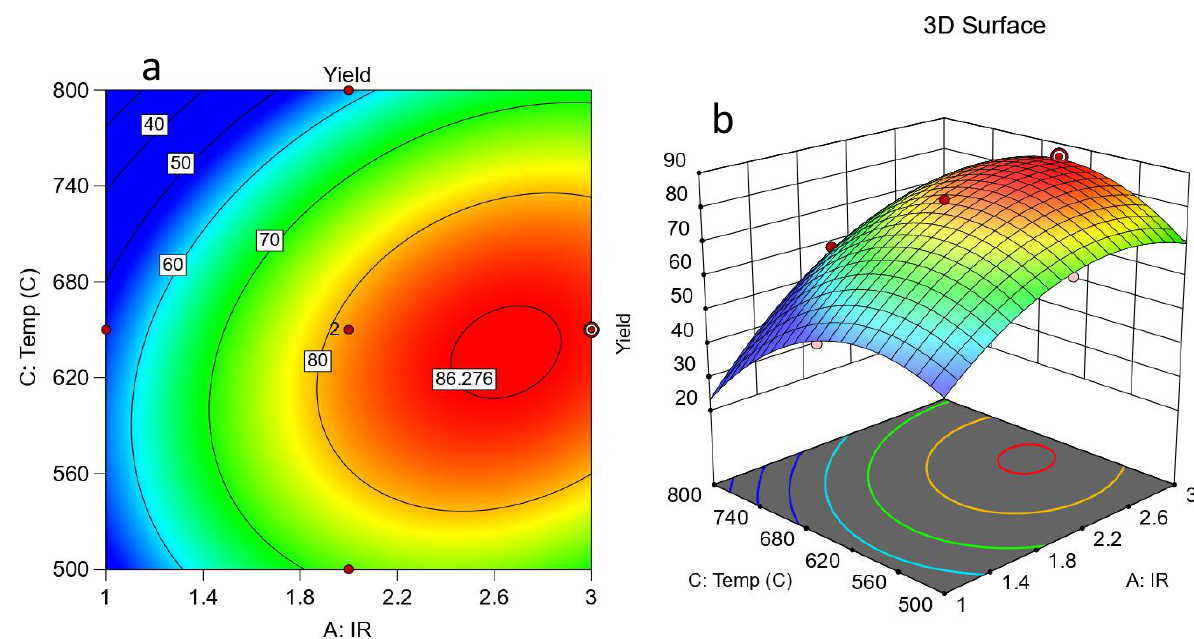
Fig. 6. The interaction between the impregnation ratio and temperature a) contour b) 3D surface.